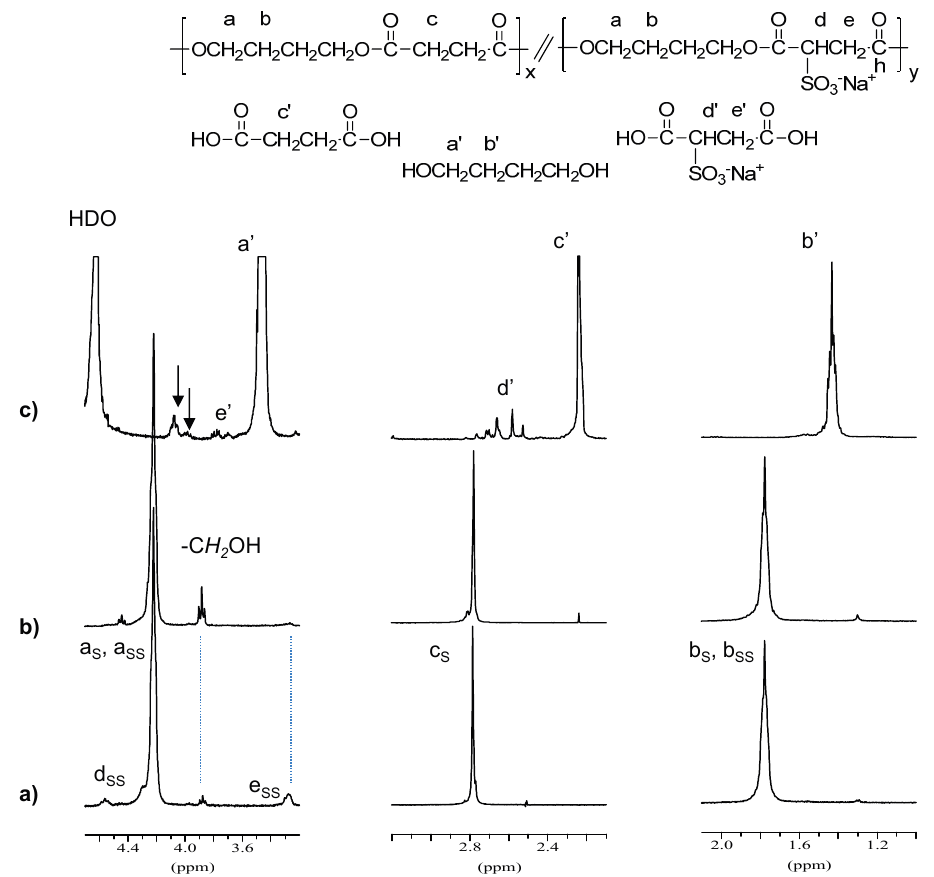
Figure 6. 1 H NMR spectra of PBS degraded in aqueous buffer, pH 10 for eight weeks. The arrows indicate signals arising from oligomers generated upon